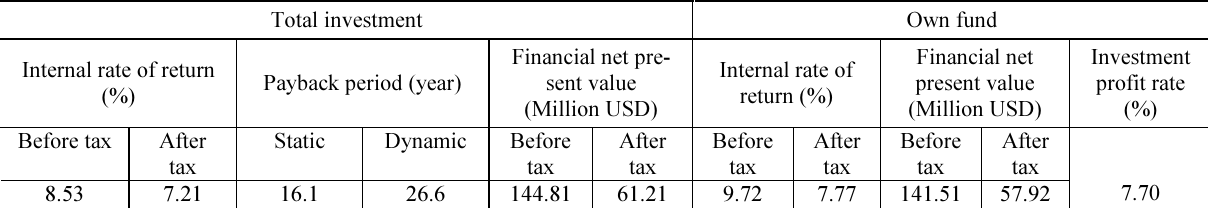
Table 2. Profitability indices of total investment in Nanjing Yangtze River Tunnel Total investment Own fund Internal rate of